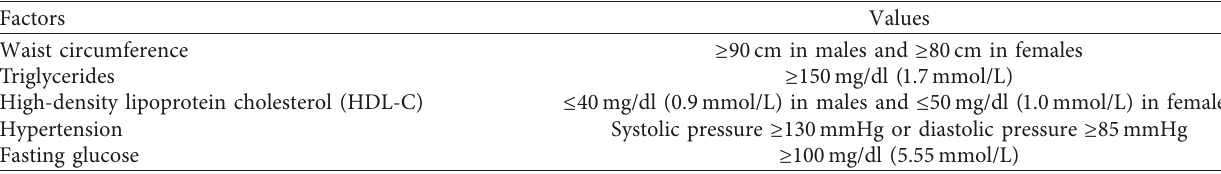
Table 1: Risk factors of metabolic